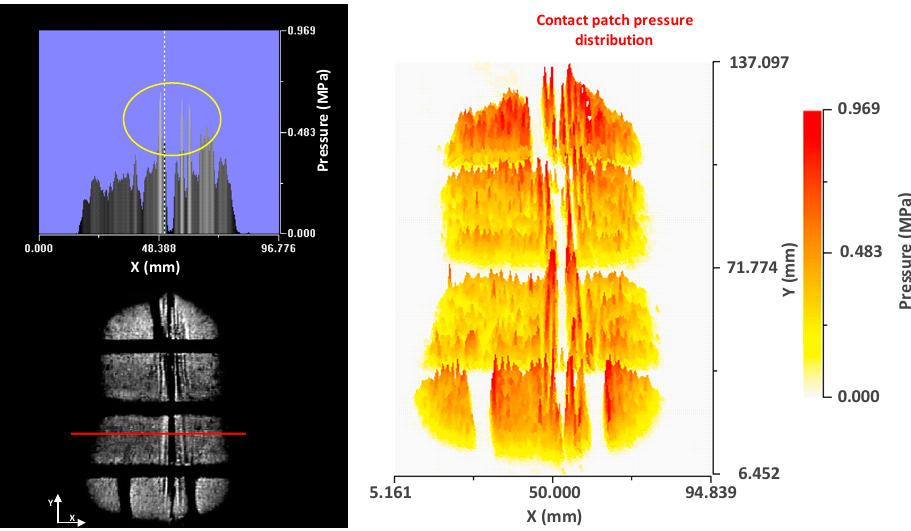
Figure 24. Cross profile ( left ); and contact patch pressure distribution ( right )—transverse cut.